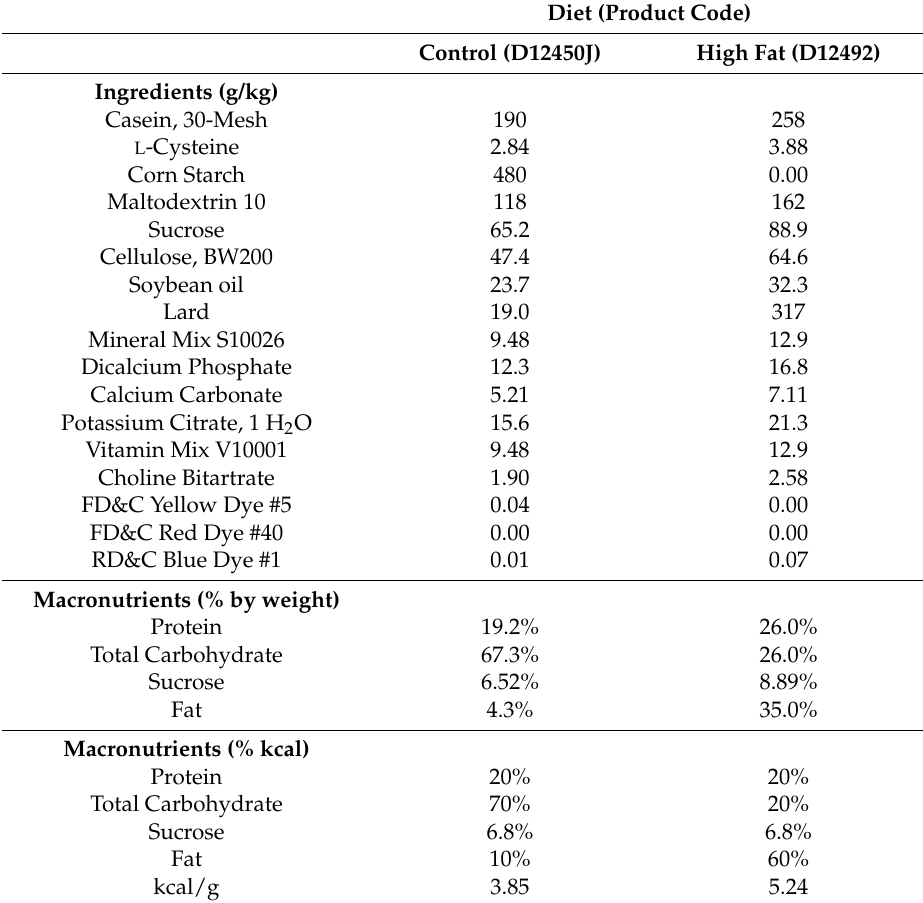
Figure 1. Study Schematic. BAT, brown adipose tissue; BW, body weight; HF, high fat; IP, intraperitoneal; LF, low fat; LPL, lipoprotein lipase; NEFA, nonesterified fatty acids; TAG, triacylglycerides; WAT, white adipose tissue. Table 1. Diet composition 1 .